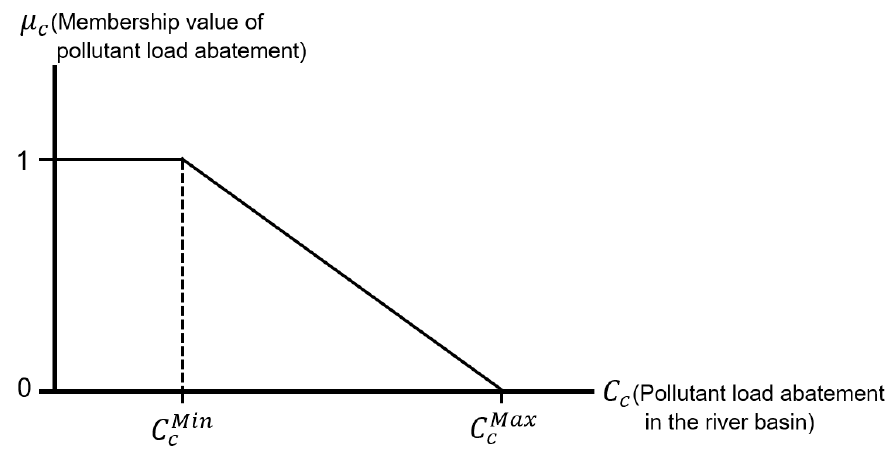
Figure 2. Membership function of pollution load abatement.